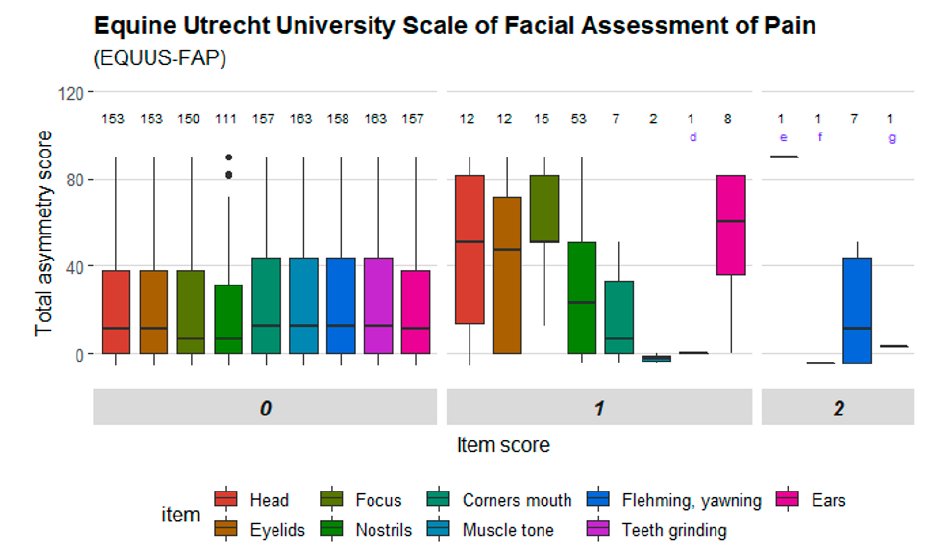
Figure 2. Distribution of item scores for Equine Utrecht University Scale of Facial Assessment of Pain (EQUUS-FAP). Total asymmetry score is presented on the y-axis. Scale items are presented on the x-axis and divided into the item scores given (ranging from 0 to 2). Letters in the diagram: d—teeth grinding/moaning, e—nostrils, f—corners of mouth/lips, g—teeth grinding/moaning.